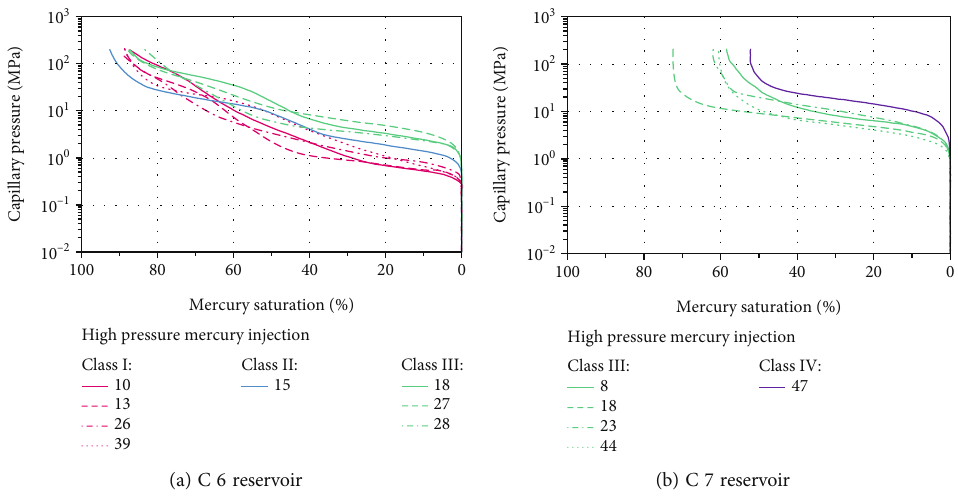
Figure 7: The capillary pressure curve of high-pressure mercury penetration